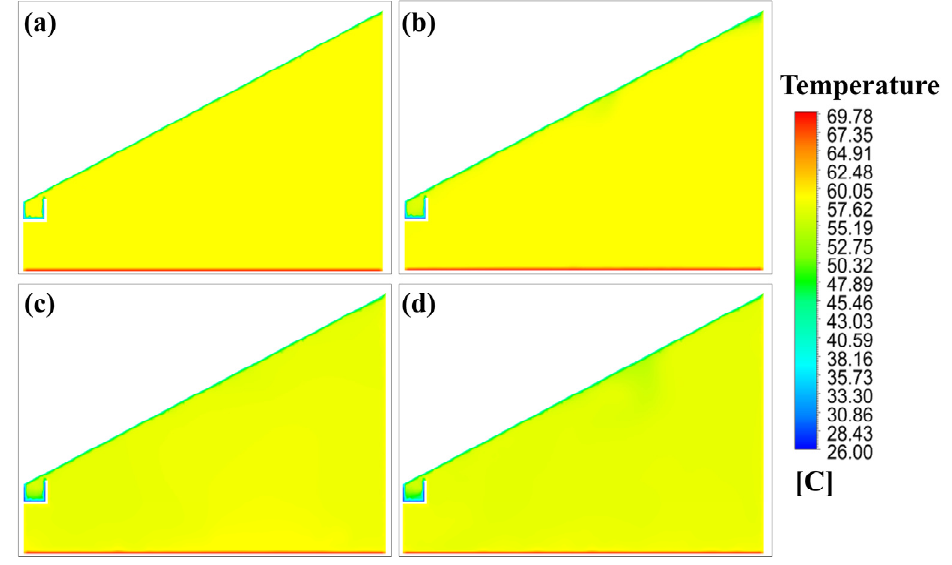
Figure 10. Temperature profile over the analysis time ( a ) 0; ( b ) 30; ( c ) 50; and ( d ) 60 min.